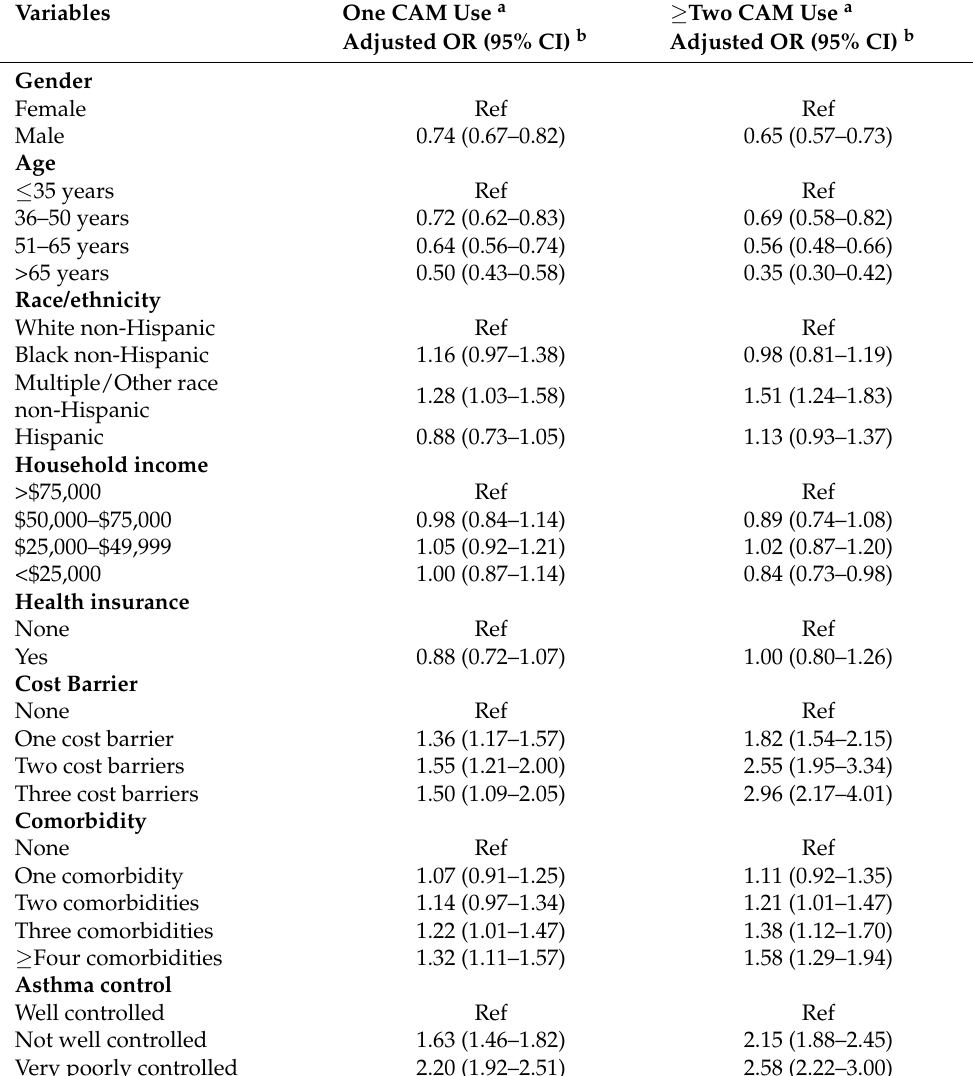
Table 4. Multinomial logistic regression of sociodemographic and health factors associated with CAM use among US adults with current asthma: Behavioral Risk Factor Surveillance System Asthma Call-back Survey,